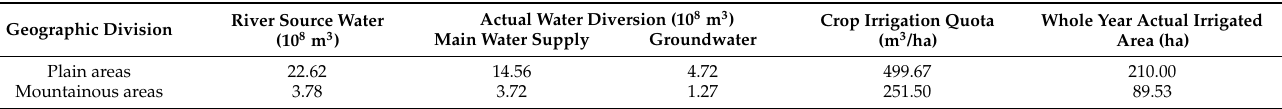
Table 1. Status of water resources in plain and mountainous areas of Zhangye City.